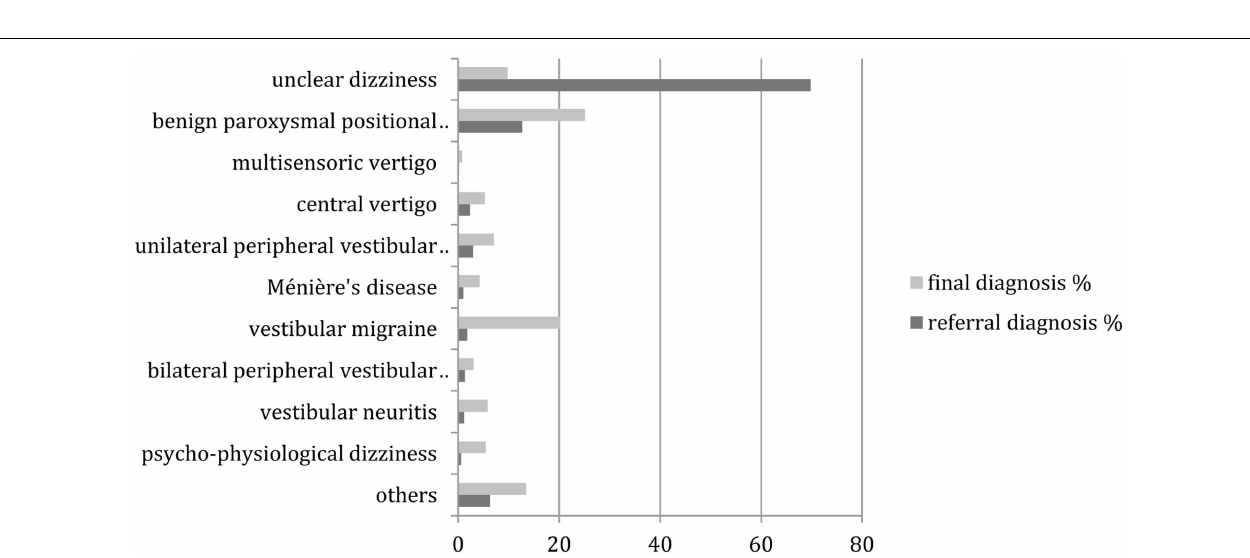
FIGURE 2 | Distribution of referral and final diagnoses in patients under the age of 65years. “Others” include presyncopal dizziness, perilymph fistula, ocular vertigo, afferent ataxia, and dizziness after head trauma,